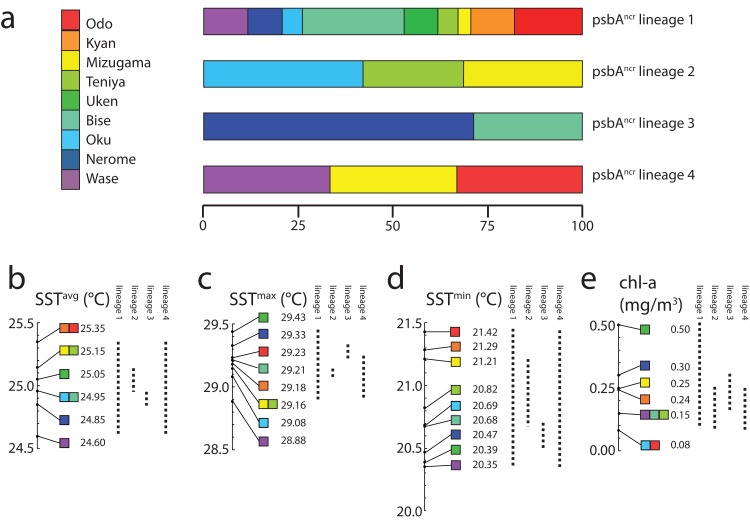
Symbiodinium psbAncr lineage distribution by environment.Distributions are represented as (A) proportions of each lineage in each sampling site; or as ranges (dotted lines) with respect to (B) SSTavg values, (C) SSTmax values, (D) SSTmin values, and (E) chl-a values. All colors correspond to sample site designations in (A).